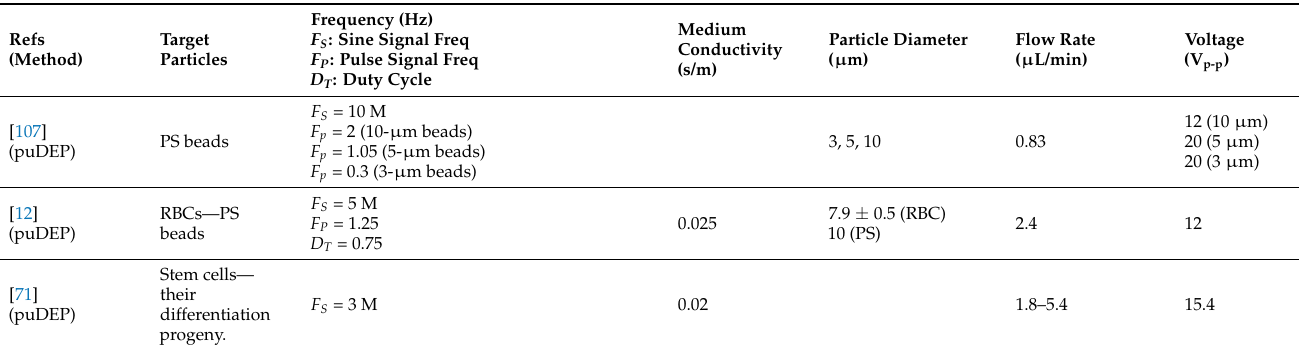
Table 4. Time varying methods’ reported